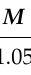
( c ) OCR = 2, ( d ) OCR = 1.5, ( e ) OCR = 1, ( f ) stress paths corresponding to different OCR.